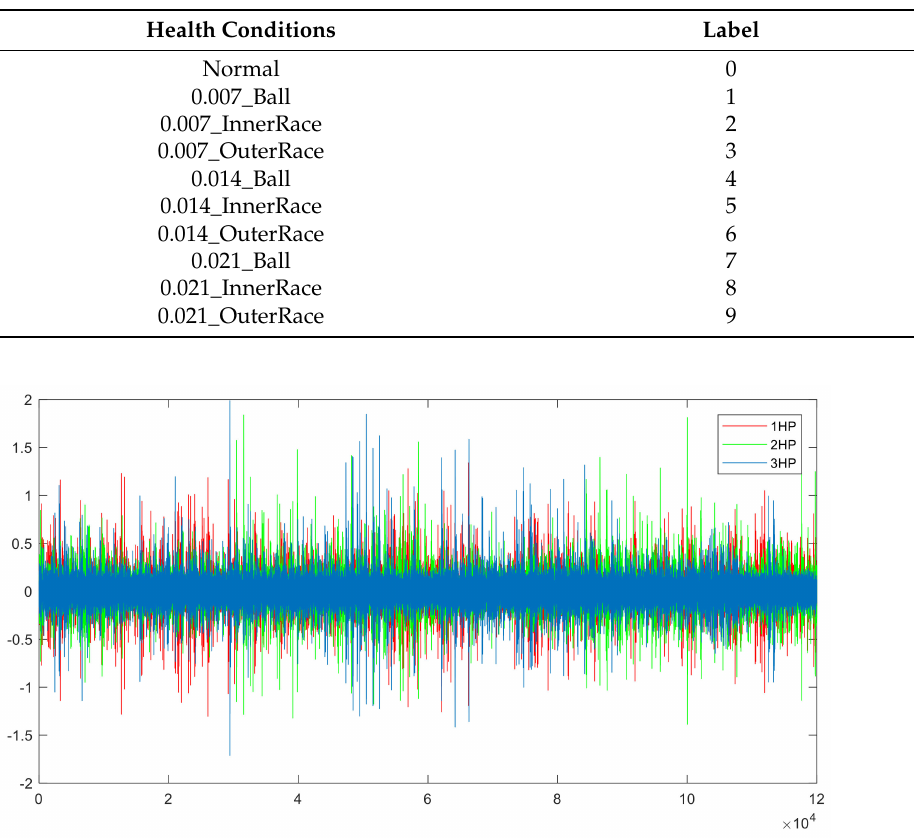
Table 3. Label assignment.